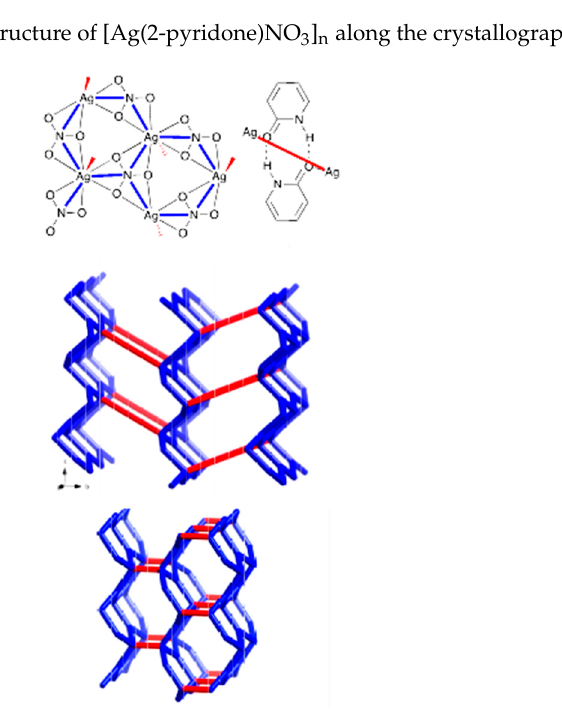
Figure 4. Node assignment (top) and resulting ins-net in [Ag(2-pyridone)NO 3 ] n ; 2 (center) and the ideal ins-net (bottom).